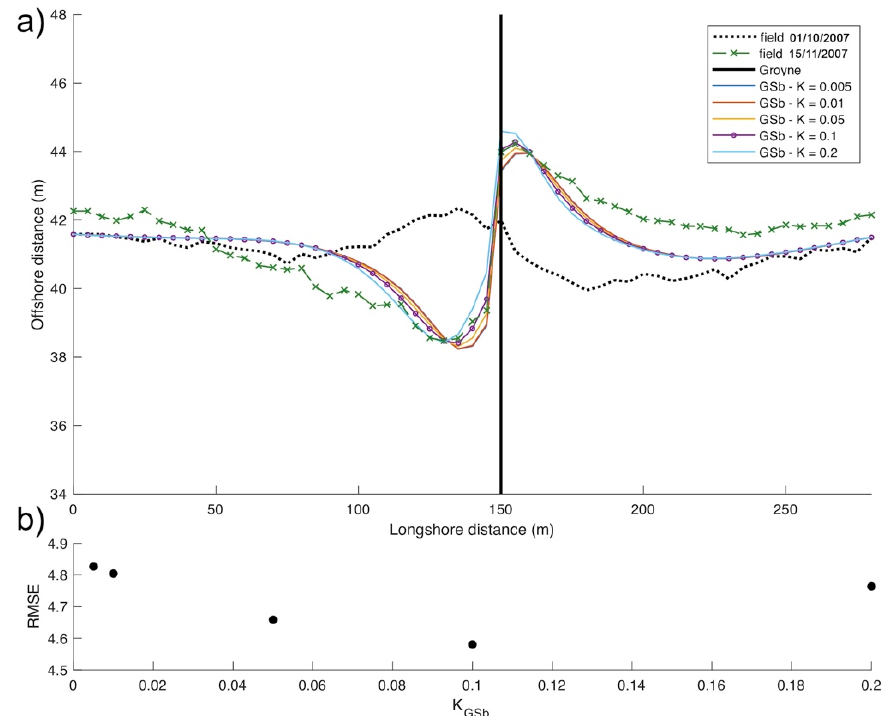
Figure 14. ( a ) Observed and calculated shorelines at the end of the simulation (45 days) for the selected values of K GSb ( b ) RMSE vs. K GSb .